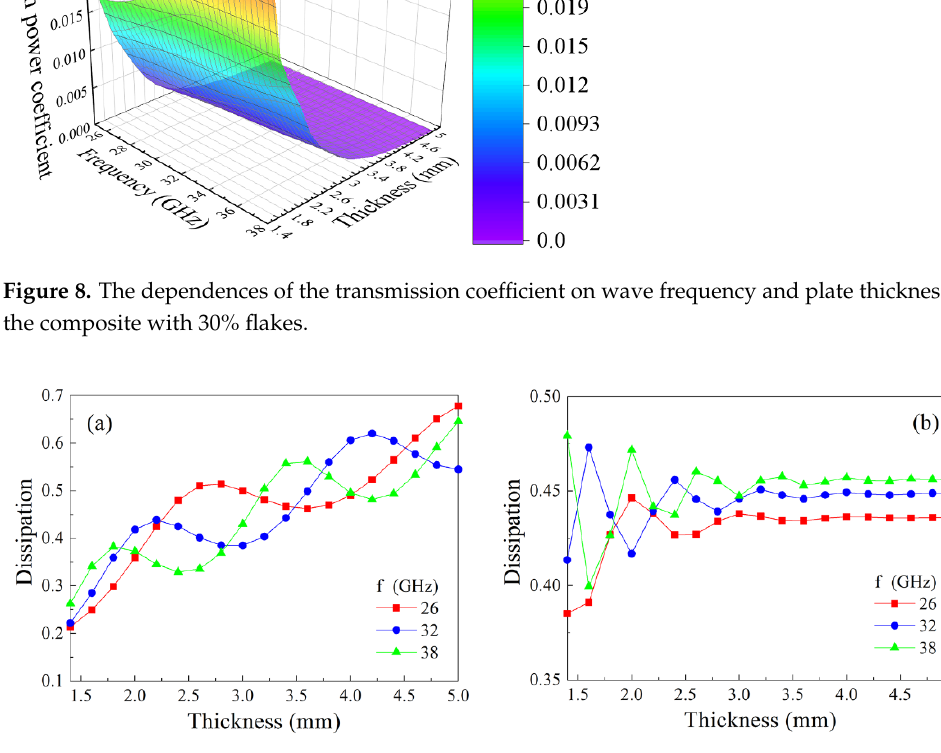
Figure 8. The dependences of the transmission coefficient on wave frequency and plate thickness for the composite with 30% flakes.